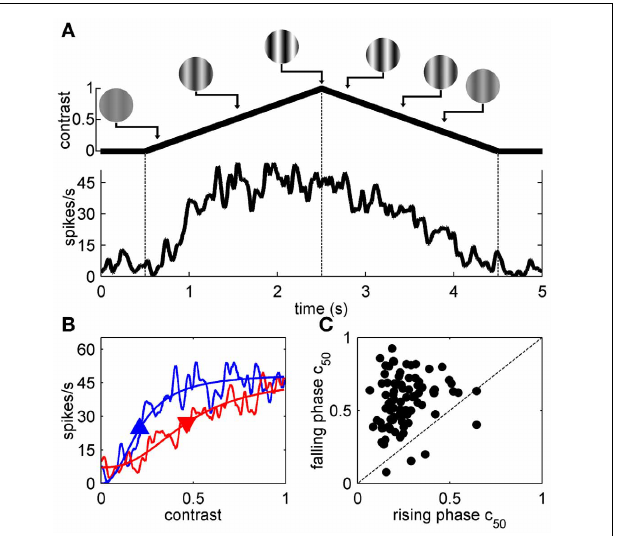
FIGURE 3 | Contrast ramps of optimal SF and TF. (A) shows the response of a representative neuron to a contrast ramp of optimal SF and TF along with a schematic demarcating the rising and falling phases of the contrast ramp with dashed lines. In (B) , the neuron’s responses to the rising (blue lines) and falling phases (red lines) of the contrast ramp are compared by folding the latency-corrected SDF back on itself so that contrast is on the abscissa and spikes/s is on the ordinate (see Materials and Methods). SDFs were fit with sigmoid functions (thin lines), and upward and downward pointing arrowheads represent c 50 values obtained from fits to the rising and falling phases, respectively. Population data comparing c 50 values obtained from fits to the rising (abscissa) and falling phase responses (ordinate) is shown in (C)